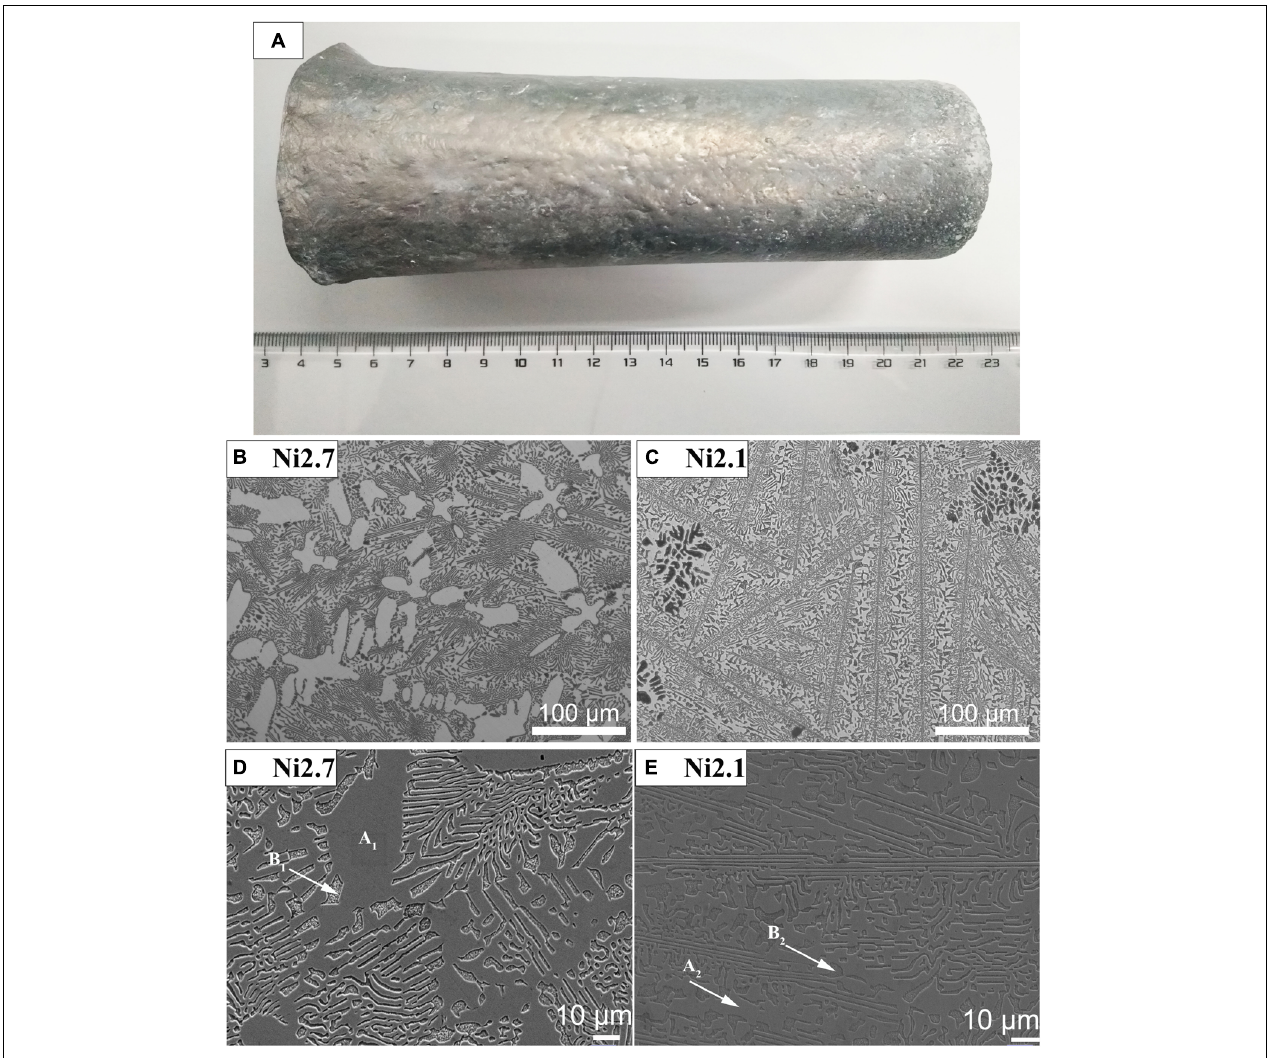
FIGURE 2 | Images of the AlCo x CrFeNi 3 . 1 − x alloys obtained using different methods. (A) Macroscopic picture of the bulk ingot; (B) OM image of the Ni2.7 alloy; (C) OM image of the Ni2.1 alloy; (D) SEM image of the Ni2.7 alloy, and (E) SEM image of the Ni2.1 alloy.